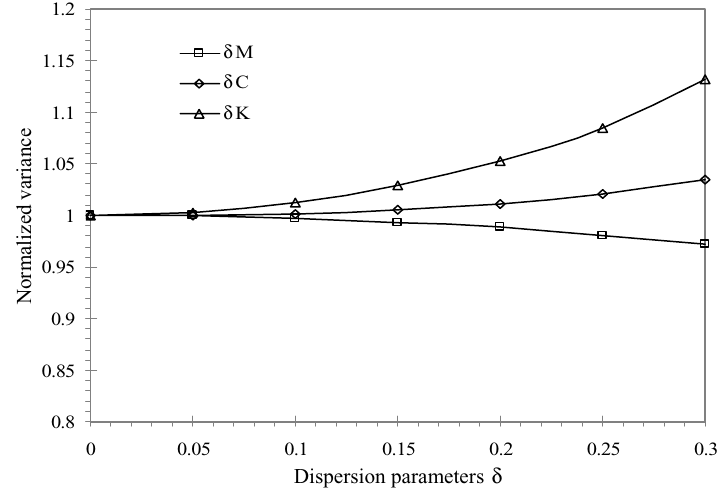
Fig. 6. Variance of Y 20 for independently varying stochastic